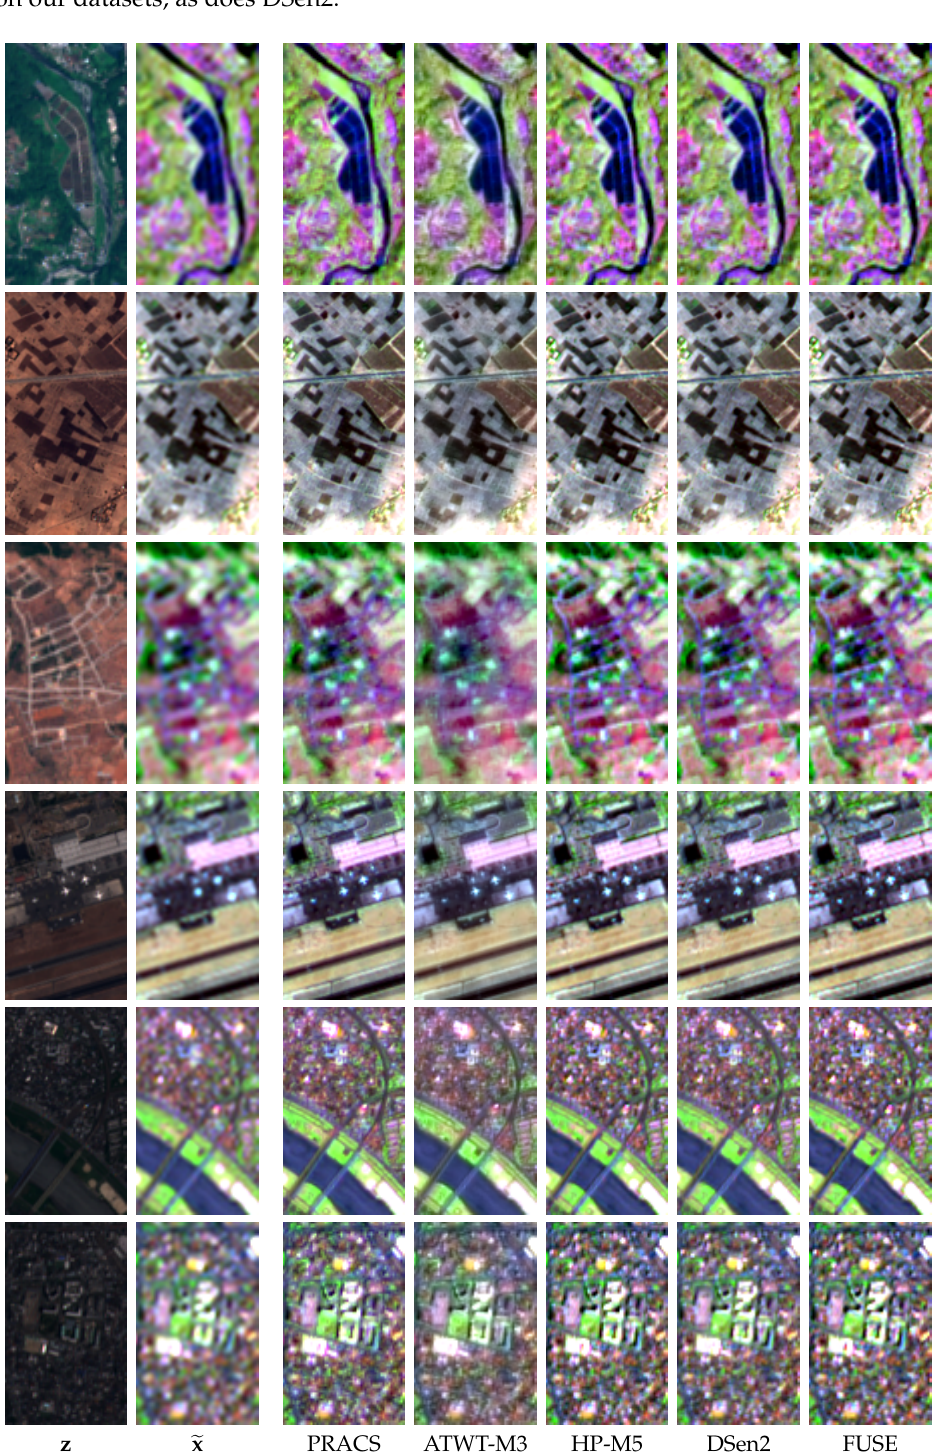
Figure 6. Full-resolution results for selected details. For each detail (row) from left to right are shown the two input components to be fused, followed by the corresponding fusions obtained by compared